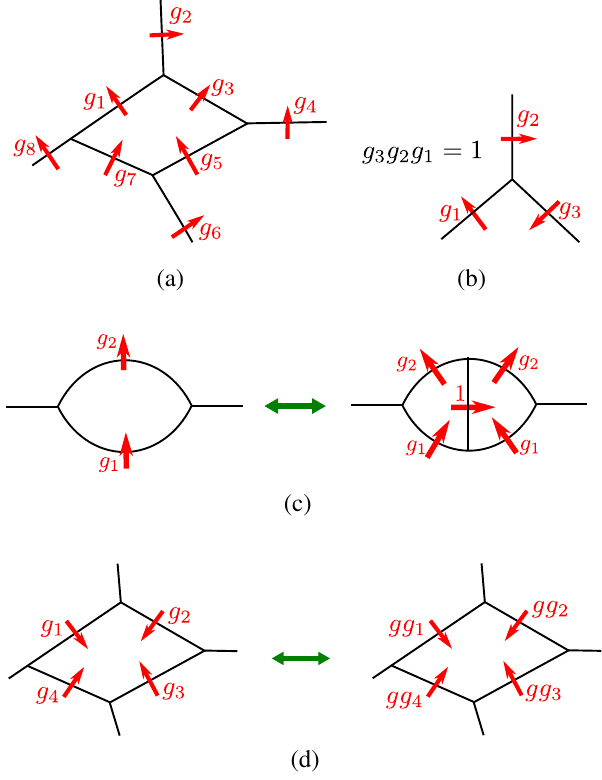
FIG. 4. The “ patches ” picture of a gauge field for an internal symmetry. (a) The manifold M is divided up into patches, and the boundaries between patches are twisted by a group element g ∈ G . (b) The flatness constraint implies that the holonomy around a vertex must be trivial. (c,d) We identify configurations that differ by dividing patches or by acting on a patch with some g ∈ G